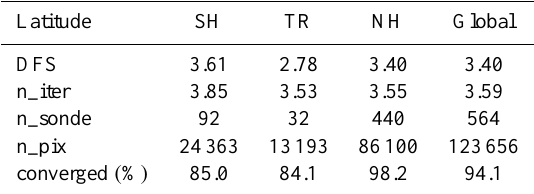
Fig. 9a. Mean of the relative differences for GOME-2 retrievals in the Northern Hemisphere. A is the mean of (apri-sonde)/apri, B is the mean of (apri-sonde_ak)/apri, C is the mean of (sat-sonde)/sat and D is the mean of (sat-sonde_ak)/sat, where “sat” is the retrieved profile, “apri” is the a priori profile, “sonde” is the sonde profile on the retrieval grid and “sonde_ak” is the sonde profile convolved with the averaging kernel. The differences with sonde_ak are also used in Fig. 8. The numbers on the left side of the plot indicate the number of collocations between GOME-2 and sondes for that layer.